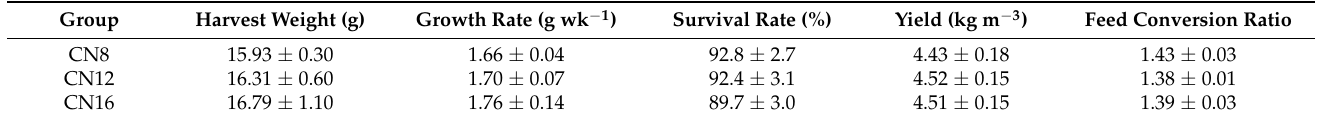
Table 1. Production performance of P. vannamei in biofloc-based tank systems during an 8-week intensive production trial with three input C/N ratios (means ± S.D., n = 3).